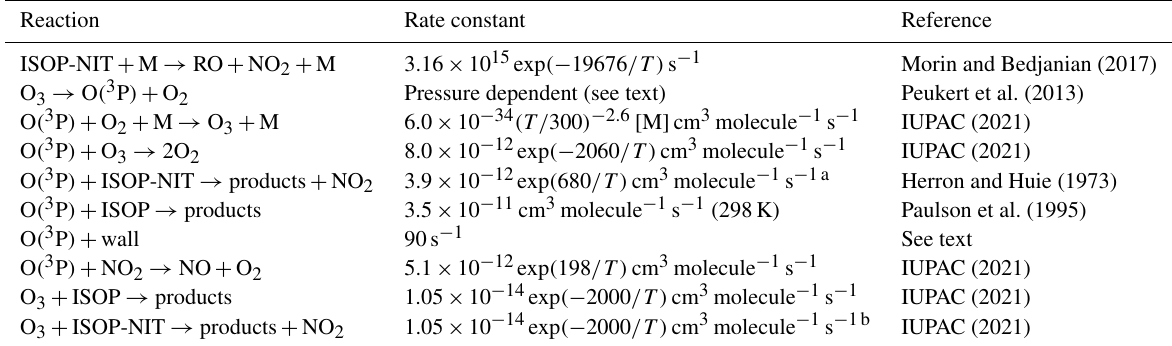
Table 1. Central reactions used for numerical simulation of the thermal dissociation of organic nitrates in TDI-2. Reaction